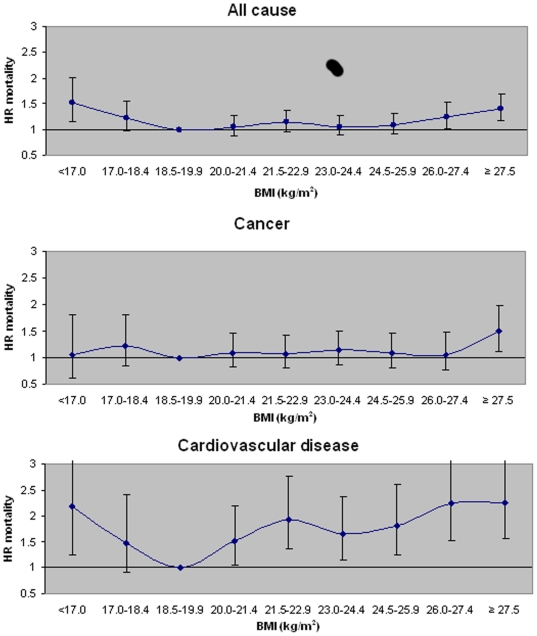
Hazard ratios of mortality incorporating BMI groups <18.5 kg/m2.Hazard ratios of all cause and cause specific mortality incorporating BMI groups less than 18.5 kg/m2 in non-smokers without reported prevalent disease and excluding deaths occurring within 5 years of baseline (N = 30,538); and adjusted for age, sex, year of enrollment, dialect, education, dietary pattern score and physical activity. Points represent hazard ratio (HR) point estimate and error bars represent 95% confidence intervals. P trend for quadratic association for all cause mortality = 0.0002. P trend for quadratic association for cardiovascular disease  = 0.0002. P trend for linear association for cancer  = 0.04.